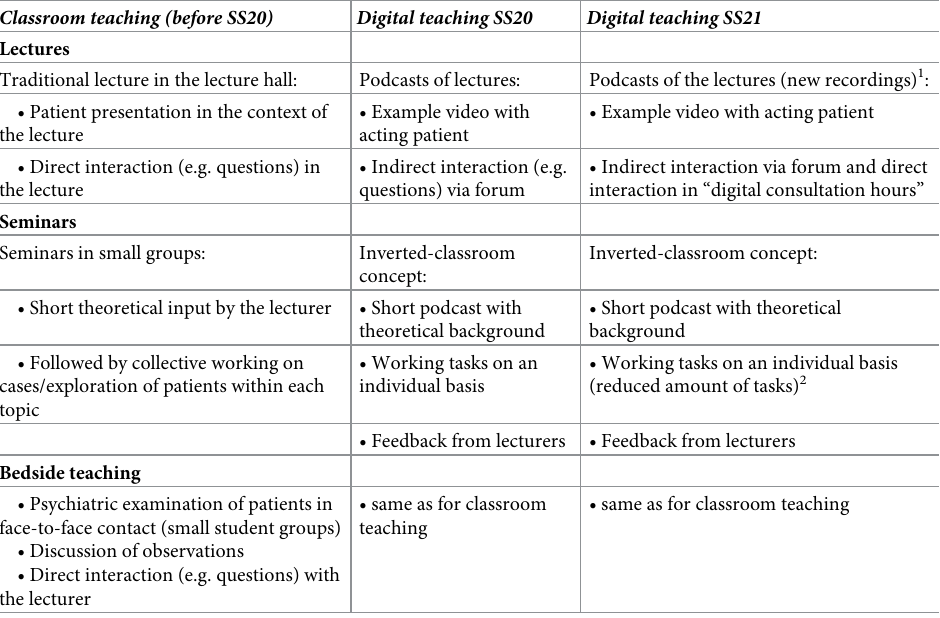
Table 1. Comparison of teaching formats: Classroom teaching vs. digital